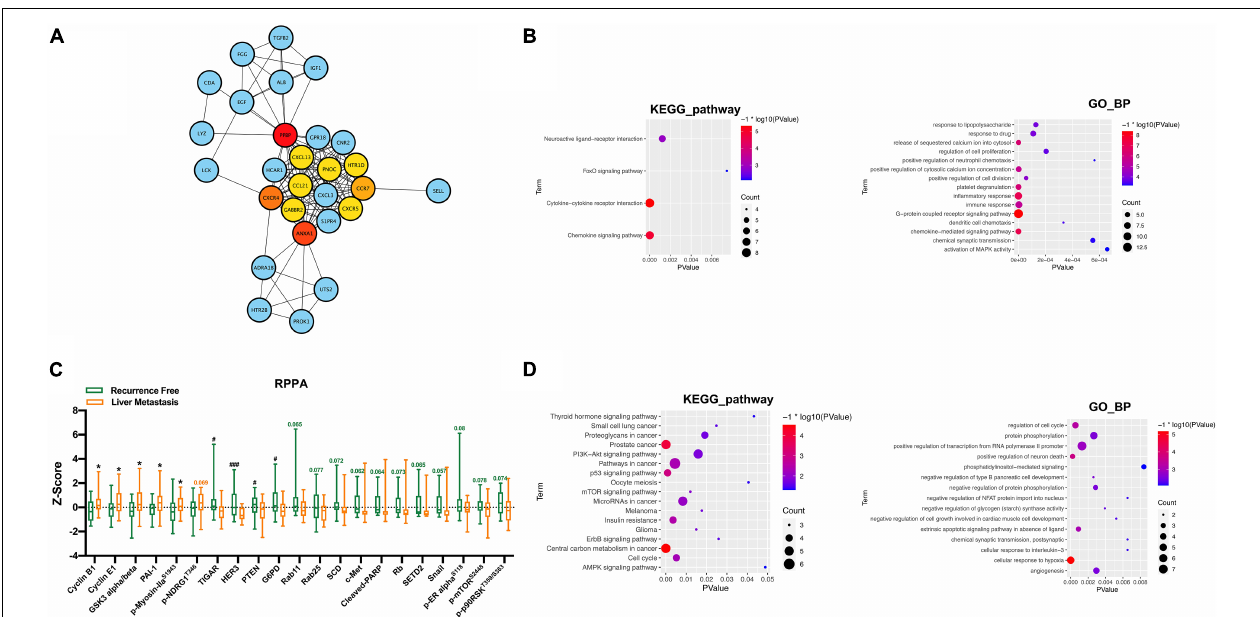
FIGURE 3 | PPI network and RPPA analysis along with functional analysis. (A) PPI network of DEGs including hub genes and subnetwork related to hub genes. (B) KEGG pathway and GO_BP analysis of recognized 28 genes. (C) RPPA analysis between the recurrence free group and the liver metastasis group. (D) KEGG pathway and GO_BP analysis of proteins with p -value less than 0.1 recognized in the RPPA analysis. * , # P < 0.05, ### P <